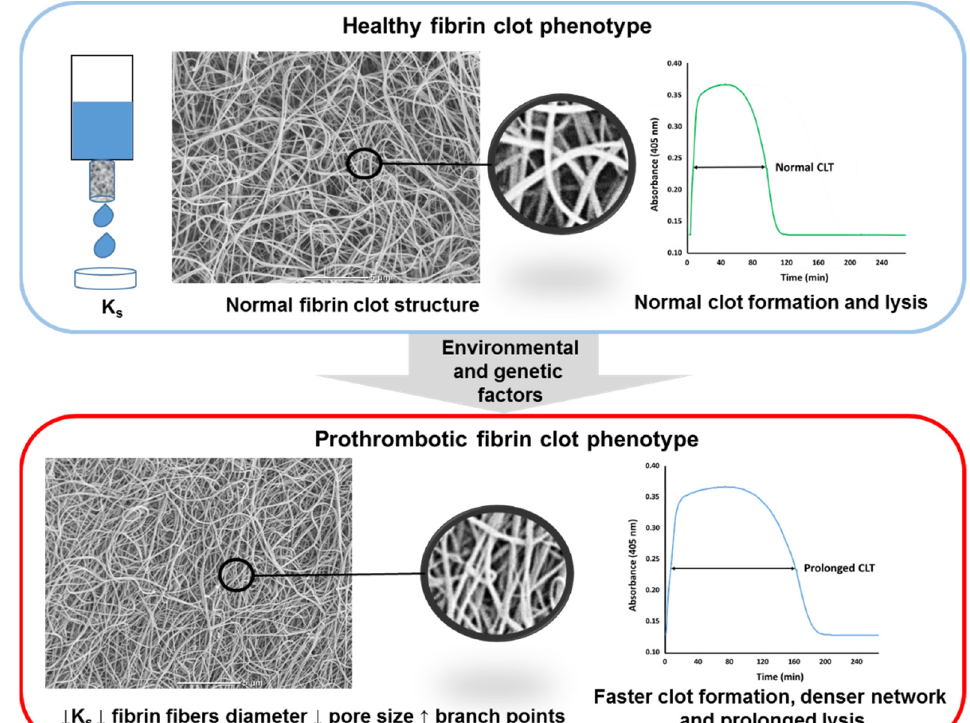
Figure 2. Fibrin clot structure differs between healthy persons and patients with atherosclerosis. A key measure describing plasma fibrin clot structure is its permeability. Reduced fibrin clot permeability (K s ) is a typical feature of the prothrom- botic fibrin clot phenotype, which is associated with lower fibrin fiber diameter, lower pore size area, and increased num- ber of fibrin branch points. Faster clot formation results in denser fibrin network (indicated by higher clot turbidity), which is relatively resistant to lysis (prolonged clot lysis time; CLT). ↑ - up-regulation, ↓ - down-regulation.